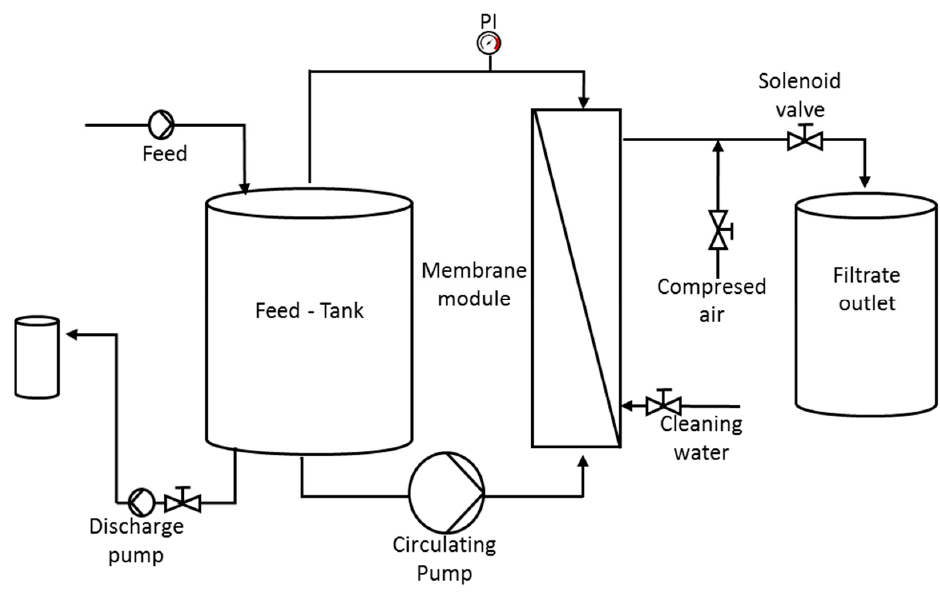
Figure 1. UF pilot plant scheme (Source: Atech Innovations gmbh).